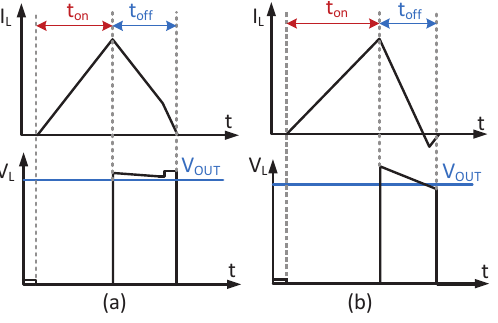
Figure 4. Detailed diagrams when ( a ) PM2 turns off early; ( b ) PM2 turns off